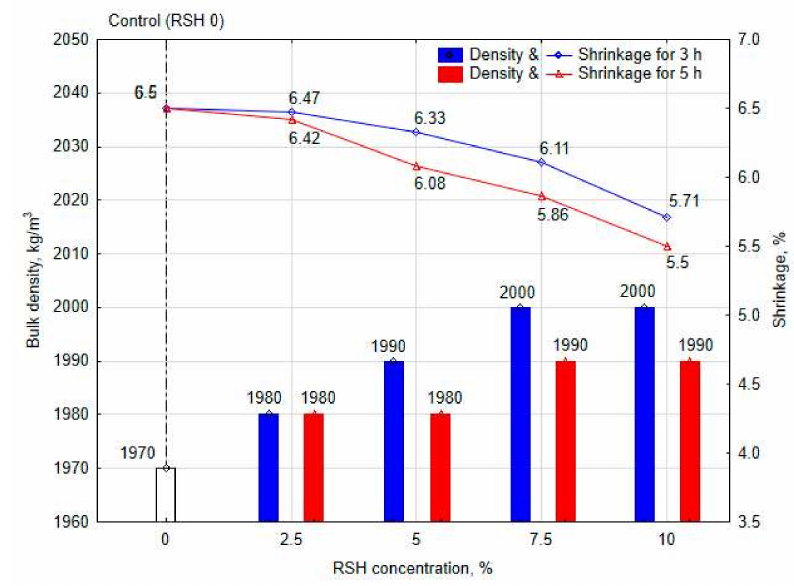
Figure 4. Physical properties of stabilized clay